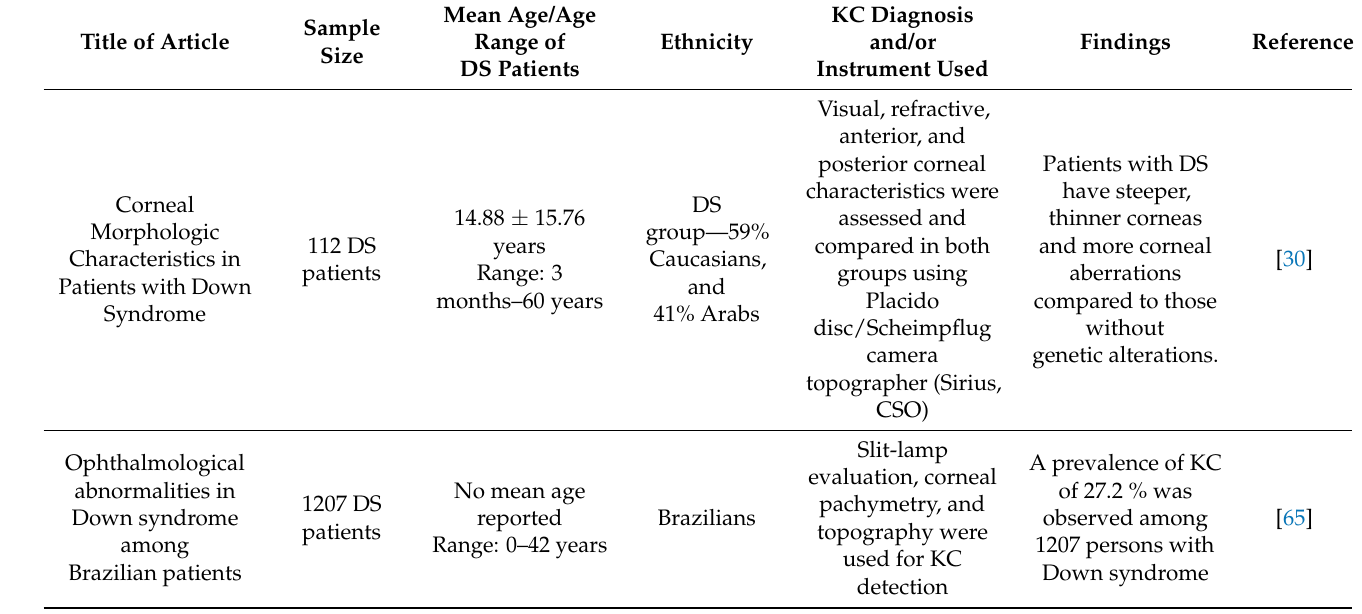
Table 1. Literature studying the relationship between Keratoconus and Down